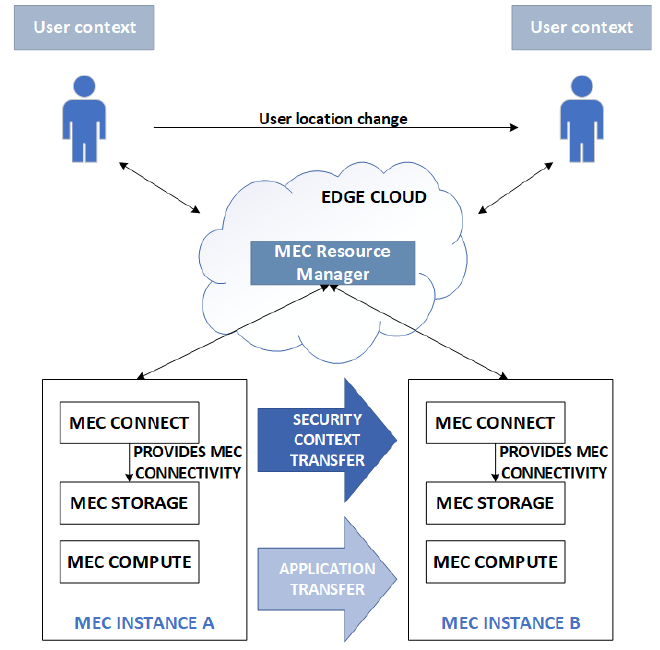
Figure 1. The scheme of security context transfer in the 5G edge computing